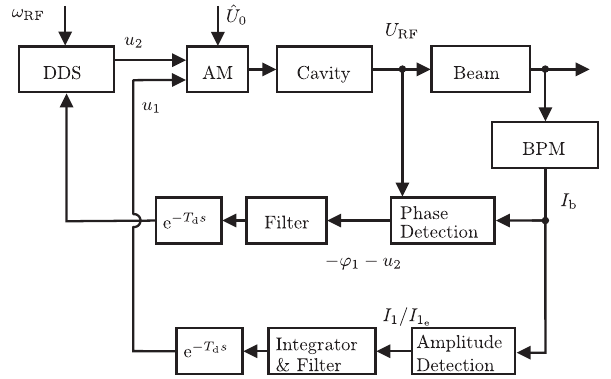
FIG. 5. Control loops of SIS18. DDS: direct digital synthesis; AM: amplitude modulator; BPM: beam position